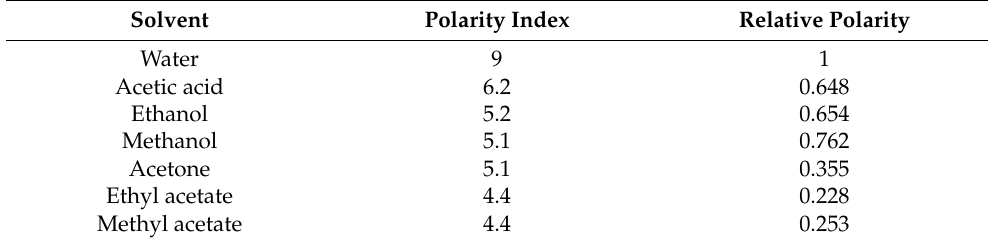
Figure 1. A diagrammatic representation of maceration extraction. ( a ) Sample and solvent mixed and kept for 7 days. ( b ) Straining of liquid and pressing the remaining marc. ( c ) Filtering out more clear liquid. Table 3. Polarity of various extraction solvents .